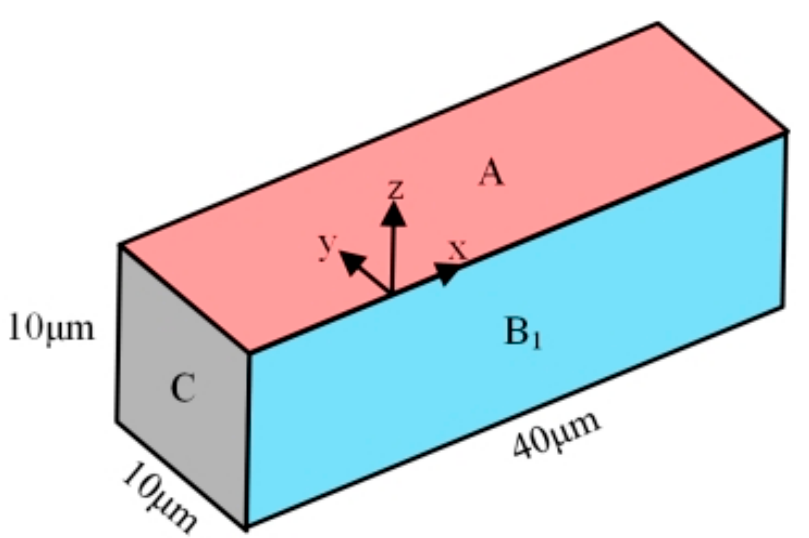
Figure 3. Micro-element on the micro-bit surface.